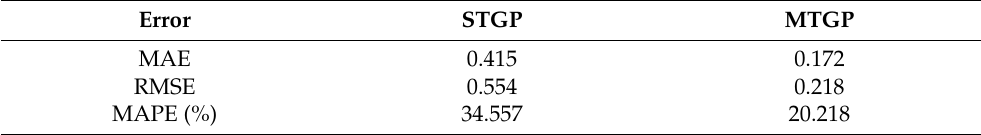
Figure 15. Imputation results of MTGP and STGP for the extreme situation (with data pre-processing). Figure 16. Prediction results of MT-LSTM, ST-MTGP, and LSTM for the extreme situation (with data pre-processing). Table 10. Error results of STGP and MTGP (with data pre-processing). Error